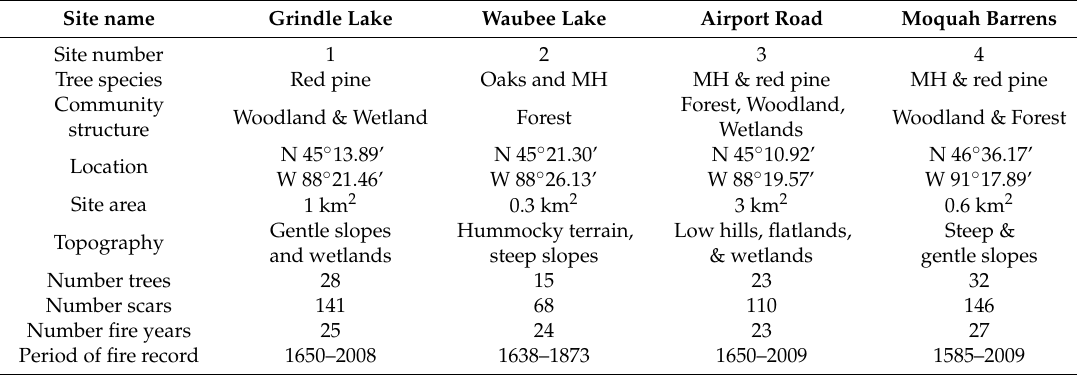
Figure 1. Locations of fire history sites (white circles) in Wisconsin’s Ecological Landscapes [20]. Numbers in circles refer to site numbers in Table 1. Table 1. Descriptions of site locations, vegetation, current dominate tree species, area, topography, and fire history records.